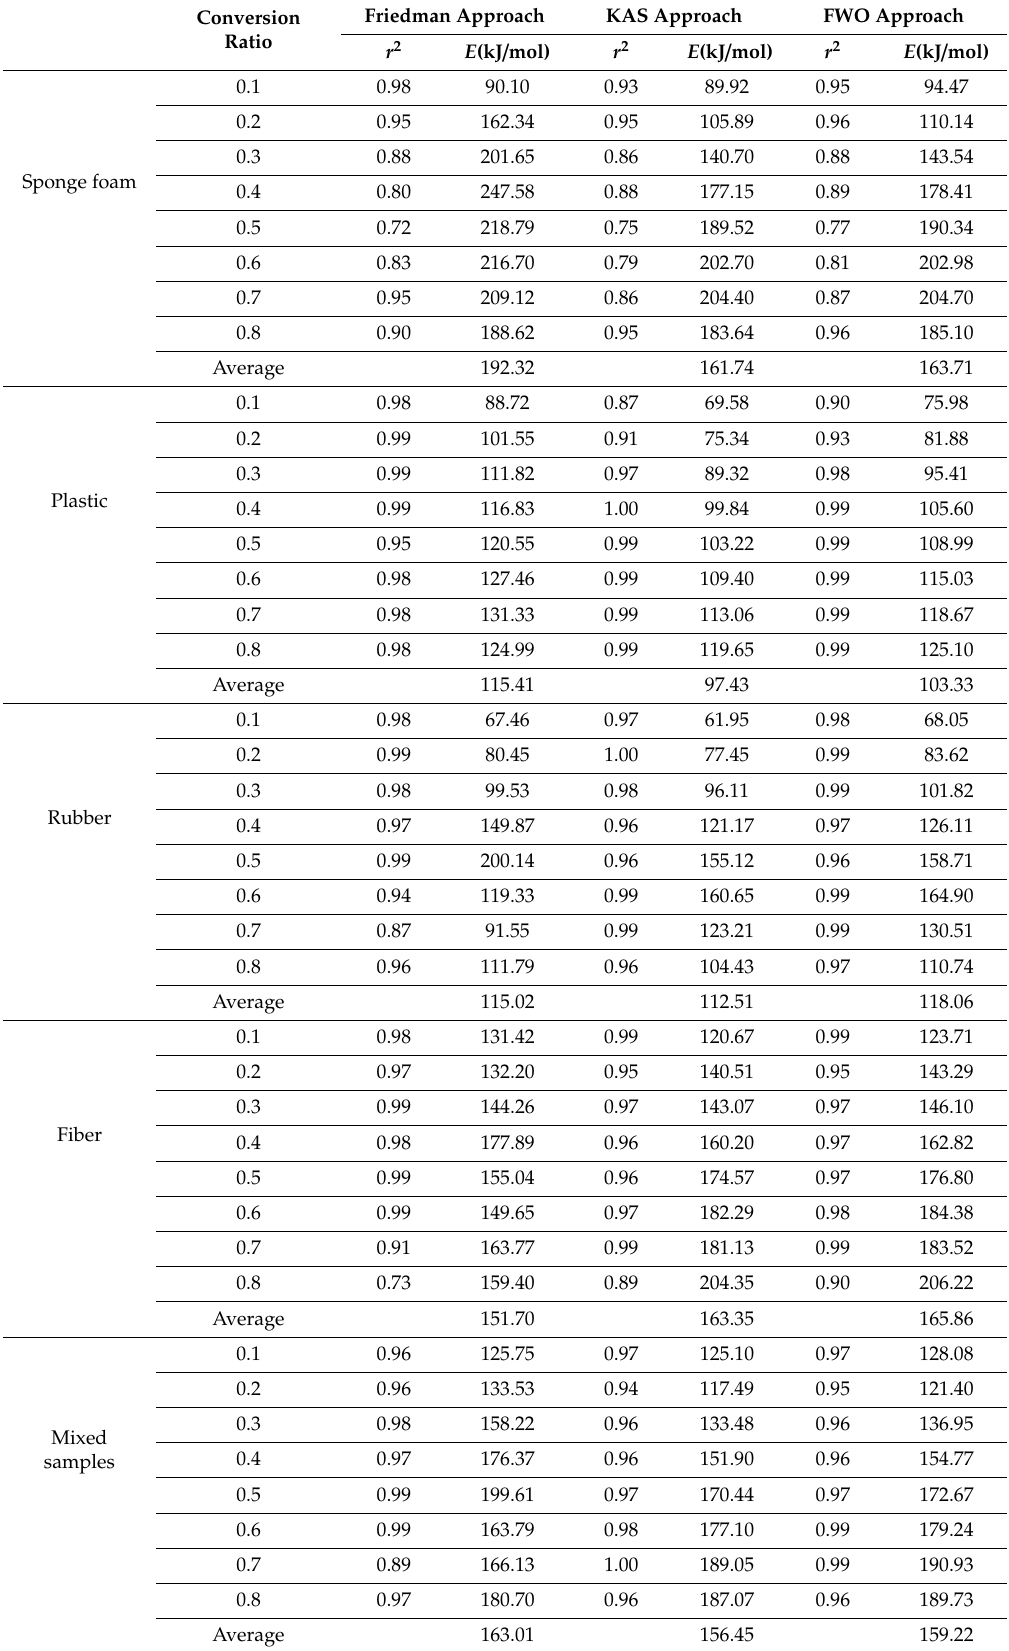
Table 2. Calculated kinetic parameter, r 2 values and E ( kJ / mol ) of the fitted equation from FWO, KAS and Friedman